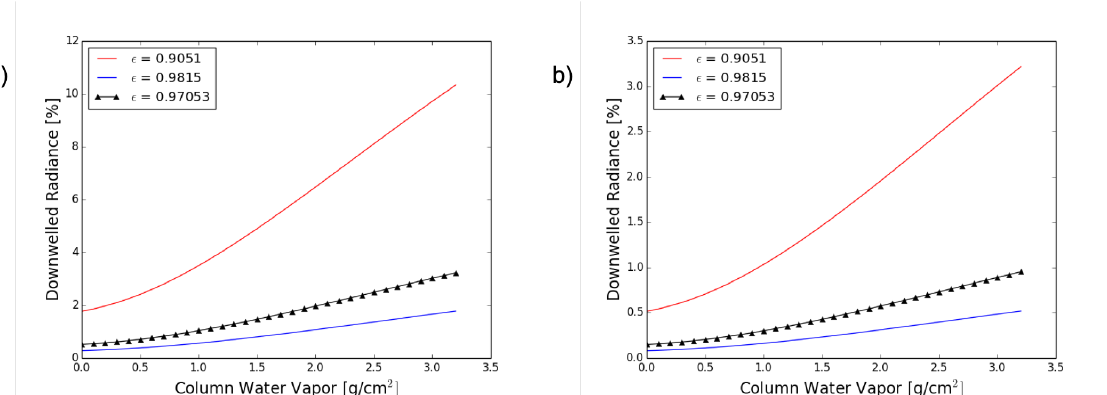
Figure 5. Downwelled radiance percentage of total radiance as a function of column water vapor with a target temperature of ( a ) 250 K and ( b ) 320 K. The results are shown for a low emissivity target (top curve), a high emissivity target (bottom curve), and the intended target of ε = 0.970 (middle